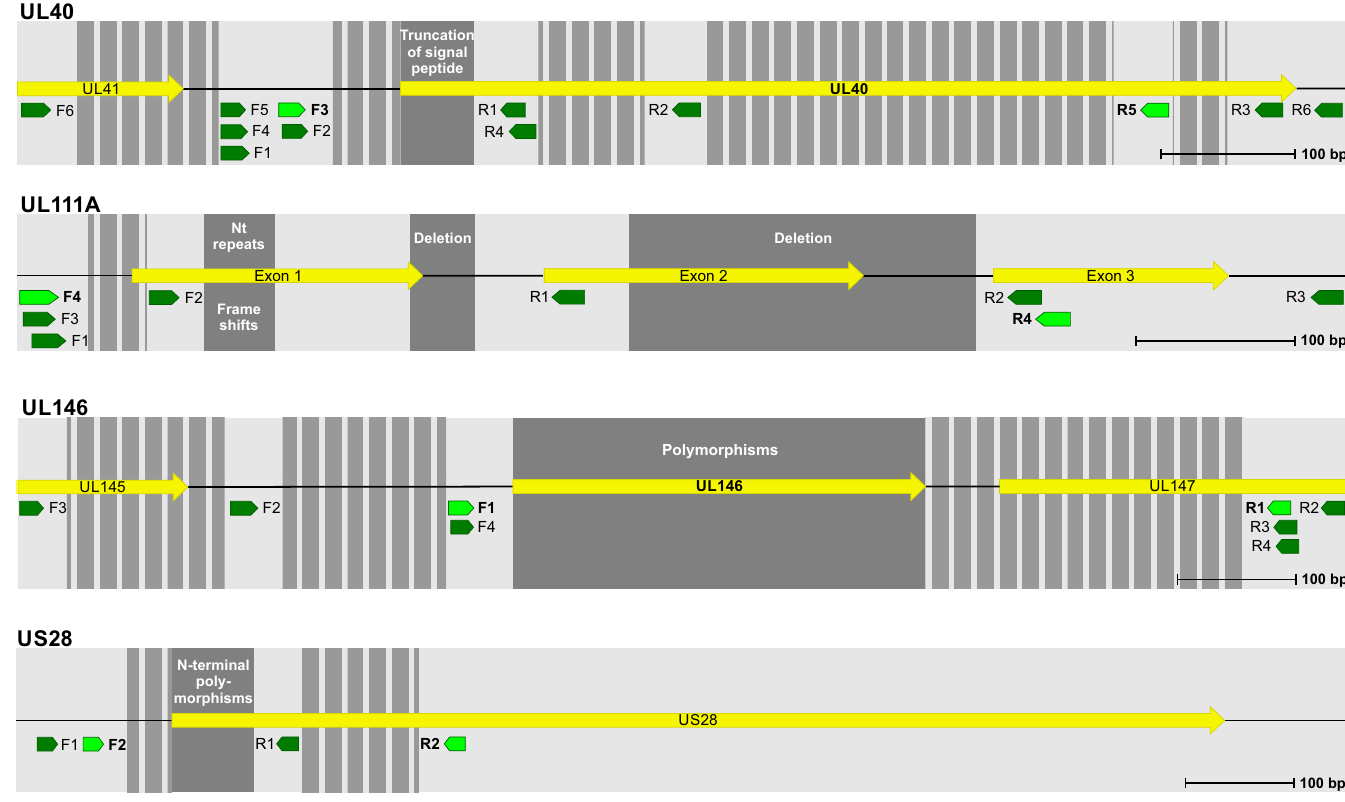
Fig 1. Overview of target genes and placement of all primers tested. Yellow arrows symbolize CMV genes and green arrows primers tested (F = forward, R = reverse). Striped regions were not suitable for primer placement due to nucleotide repeats, GC content, or inter-strain variations. Dark grey regions are the target areas for amplification. The best performing primers are marked in light green color and bold text. All elements are in a 1:1 scale.